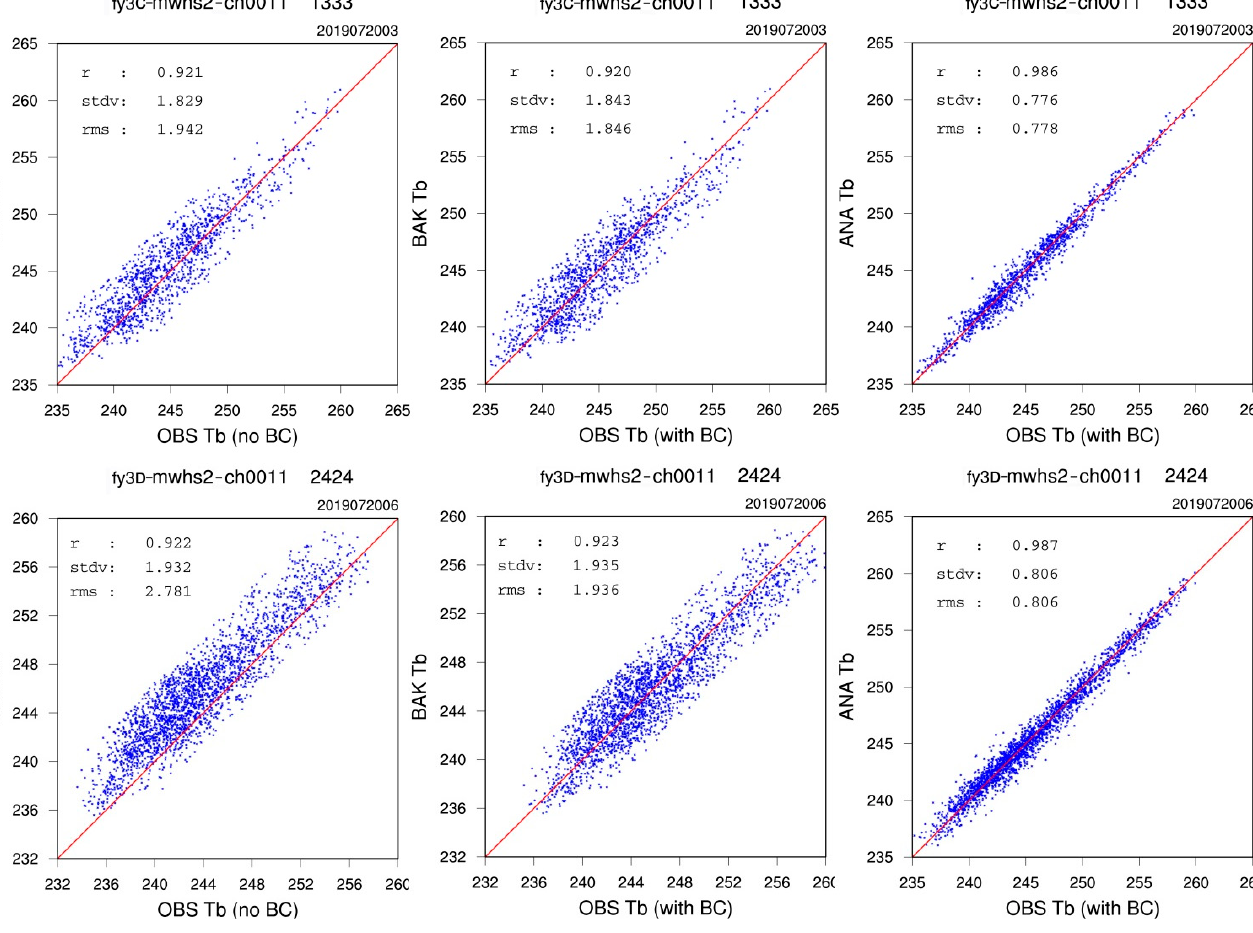
Figure 5. The scatter plots of the calculated brightness temperatures with and without bias correction vs. observations for MWHS-2 channel 11 on satellite FY-3C and FY-3D. The first row is for MWHS-2 of FY-3C at 0300 UTC and the second row for that of FY-3D at 0600 UTC 20 July 2019.